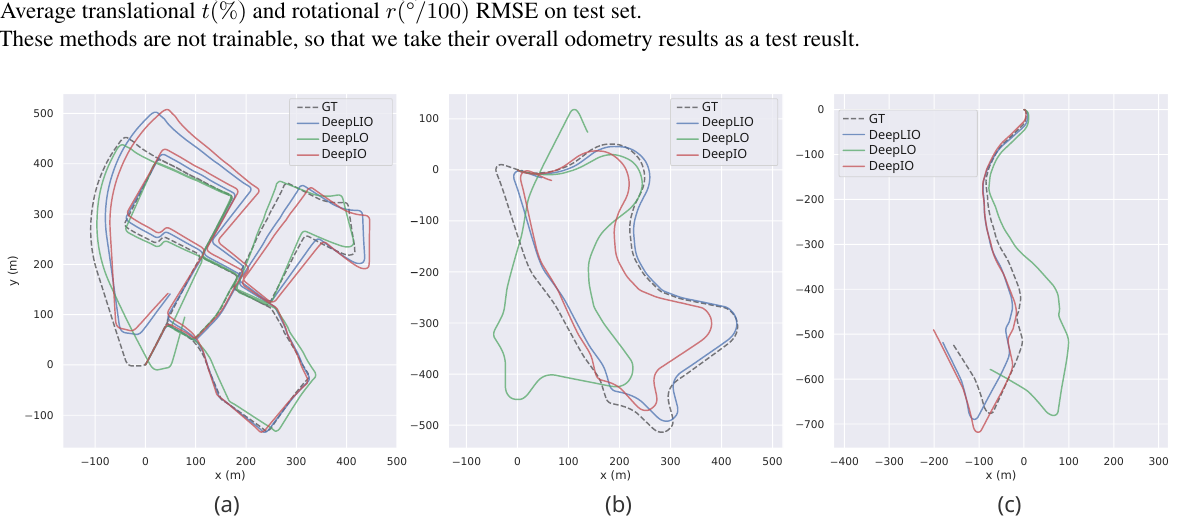
Figure 4. Trajectory comparison of DeepLIO, DeepLO and DeepIO, a) Seq. 00 of the training set, b,c) Seq. 09-10 of the test set plotted using (Grupp, 2017)